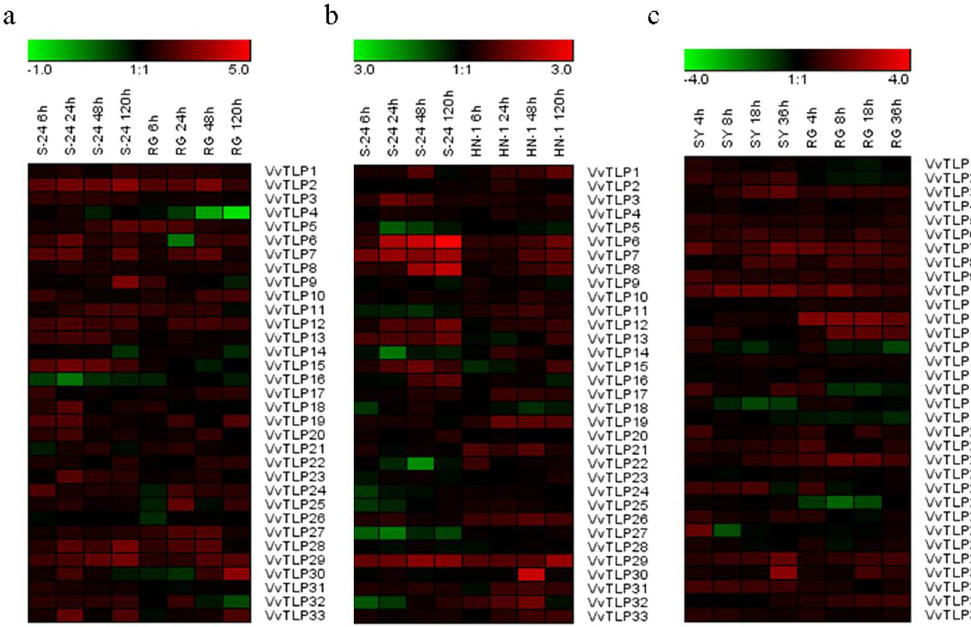
Figure 3. Expression profiles of 33 VvTLP genes. The expression data from the semi-quantitative RT-PCR analyses were analyzed and visualized into heat maps using the Gene Tools software and MeV 4.8.1. The color scale represents relative expression levels, with red and green indicating increased or decreased transcript abundance, respectively. ( a ) Expression profiles of VvTLP genes following anthracnose ( E . ampelina ) inoculation (6, 24, 48 and 120 h) in both ‘Shang-24’ and Red Globe. ( b ) Expression profiles of VvTLP genes after powdery mildew ( E . necator ) inoculation (6, 24, 48 and 120 h) in both ‘Shang-24’ and ‘Hunan-1’. ( c ) Expression profiles of VvTLP genes in response to B . cinerea inoculation (4, 8, 18 and 36 h) in both ‘Shuangyou’ and Red Globe. ‘S-24’, ‘RG’, ‘HN-1’ and ‘SY’ represent names of corresponding grape varieties. Original results are shown in Supplementary Fig. S1. The experiments were repeated three times and the results were found